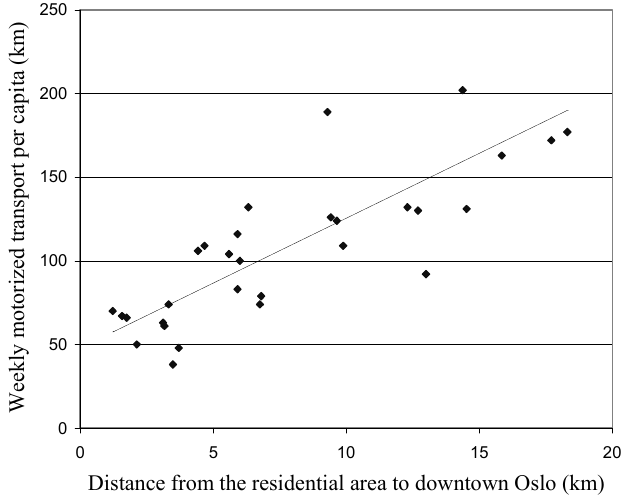
Figure 6. Average weekly motorized transport within the Greater Oslo region among respondents from residential areas located in different distances from downtown Oslo. Official trips not included. The regression line shows the relationship when controlling for a number of demographic, socio-economic and other urban structural factors 4 . Level of significance for the controlled relationship: 0.000. N = 321 households in 30 residential areas. Source: Naess, R(cid:31)e and Larsen